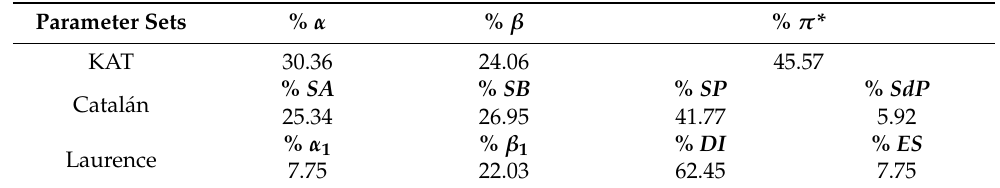
Table 4. Percentage contributions of the KAT, Catal á n, and Laurence solvent parameters to the observed solvatochromism of the BZCH